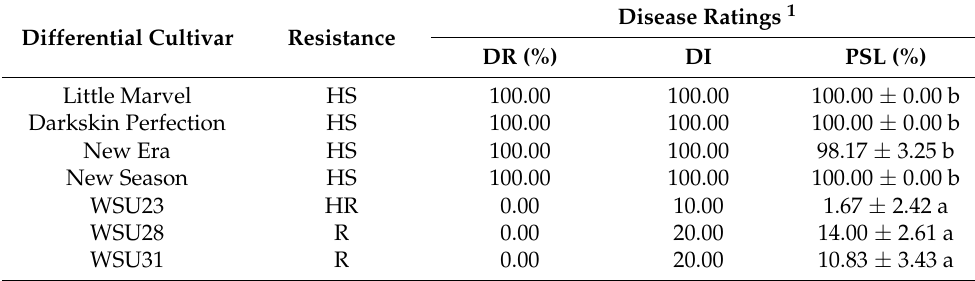
Table 1. Disease ratings of differential cultivars to the race 5 isolate PF22b of Fusarium oxysporum f. sp. pisi . Differential Cultivar Resistance